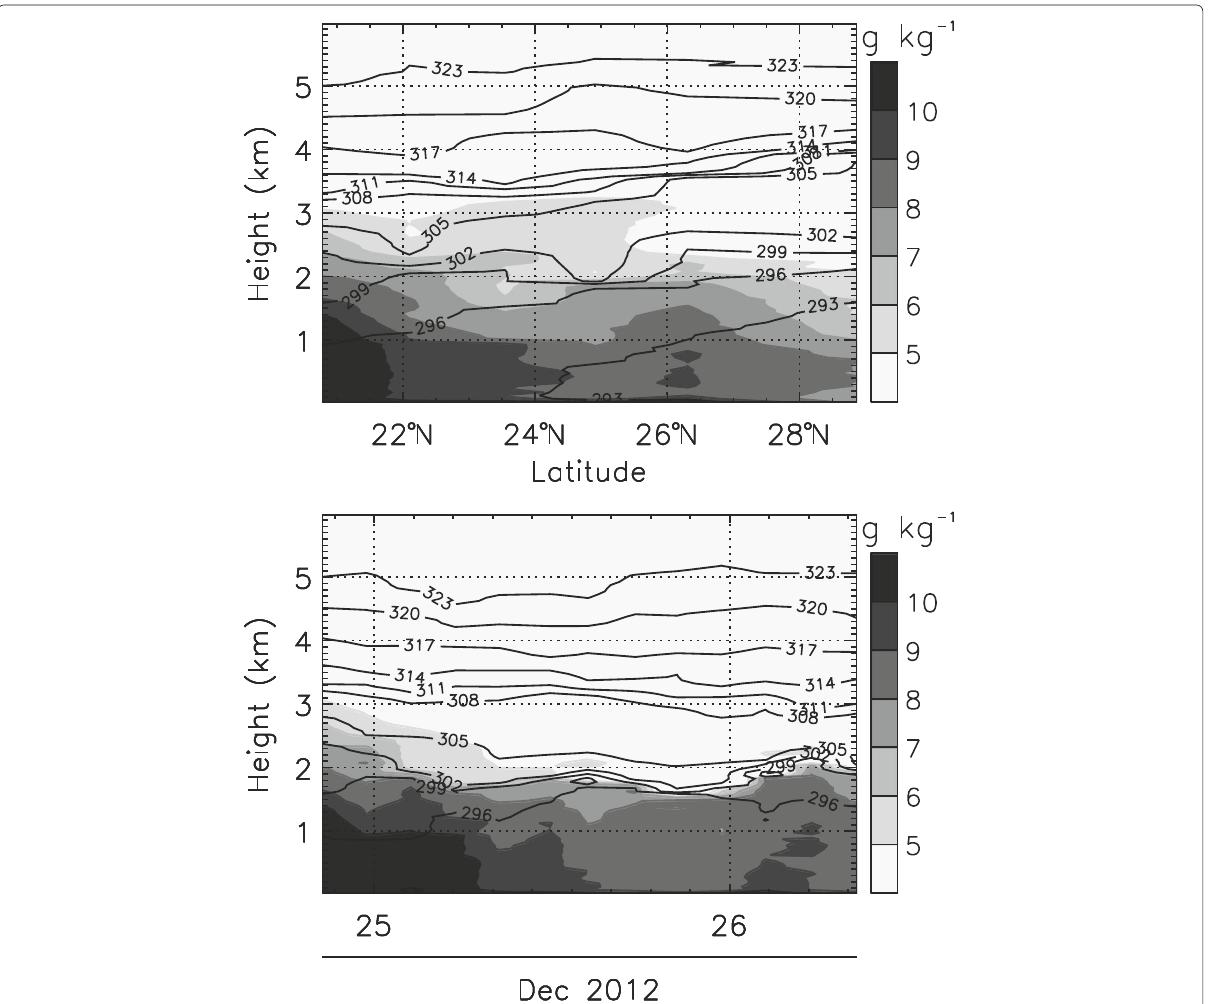
Fig. 3 The result of the radiosonde observation of the Hakuho-maru cruise. (Upper) Latitude-height section of water-vapor mixing ratio (gray shading) and potential temperature (black contours) from the moving observations from 29°N to 22°N. (Lower) The same as the upper panel, except for the time-height cross-section during the fixed-point observation during December 24–26, 2012